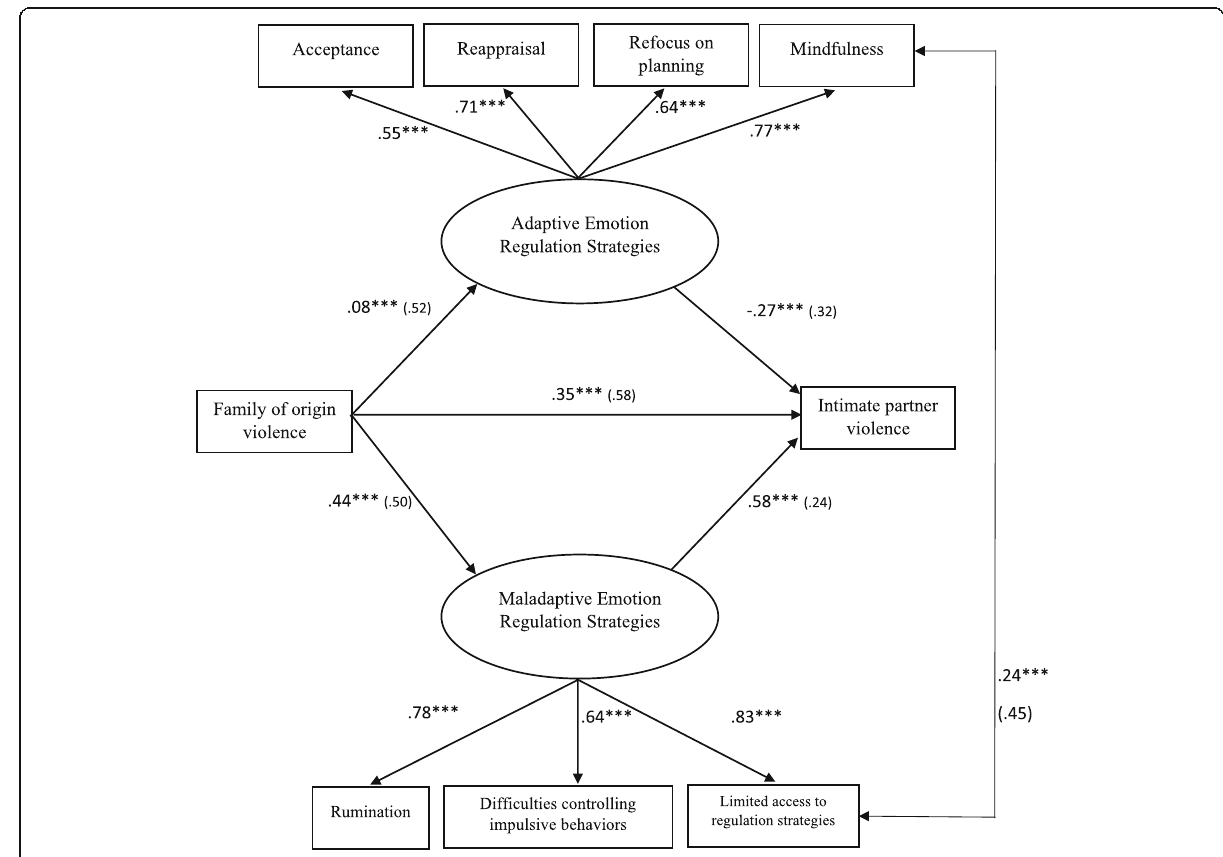
Fig. 3 Final structural model for men. Mediating effects of emotion regulation strategies on the relation between family of origin violence and intimate partner violence. Values on paths correspond to the standardized regression coefficients. Standard errors are presented in parenthesis. The maladaptive emotion regulation strategies were a significant mediator. *** p <